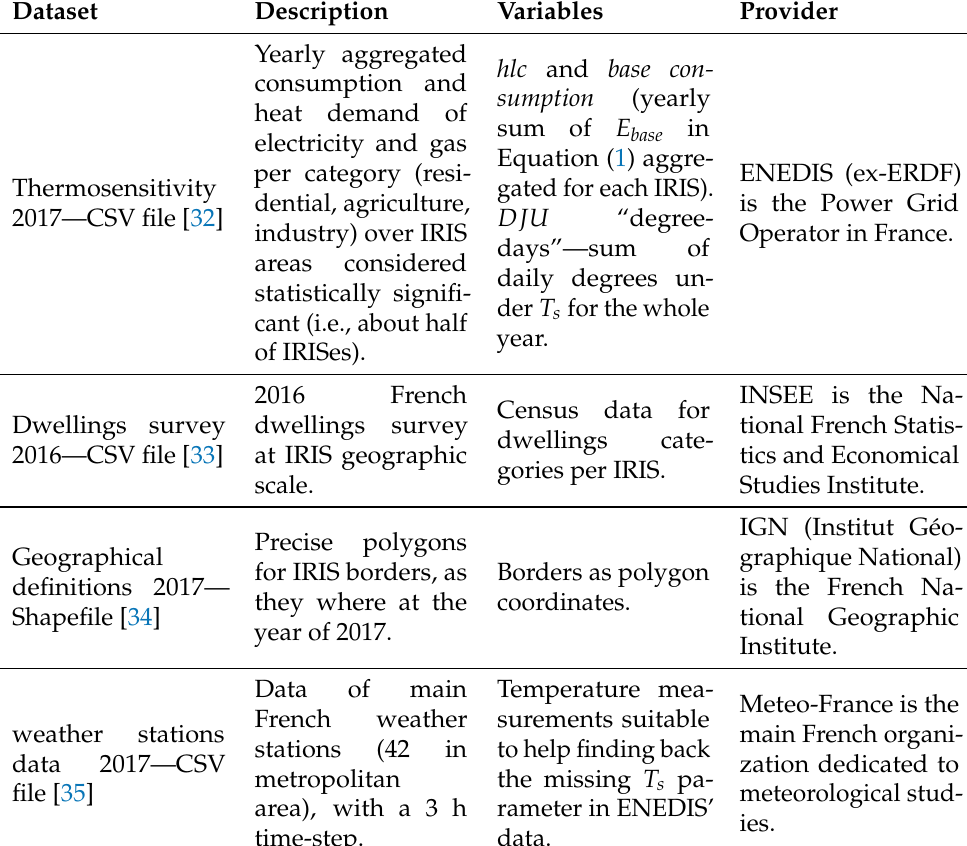
Table 3. Available